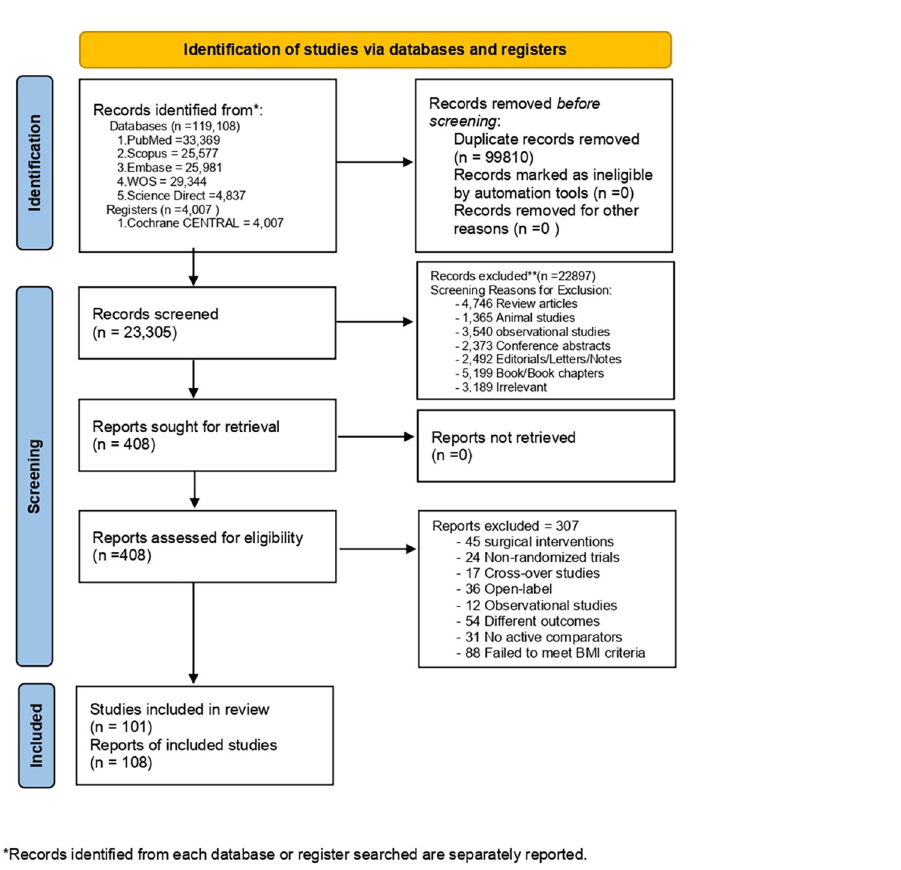
Fig 1. A PRISMA flow diagram illustrates the search results, de-duplication, screening and the selection